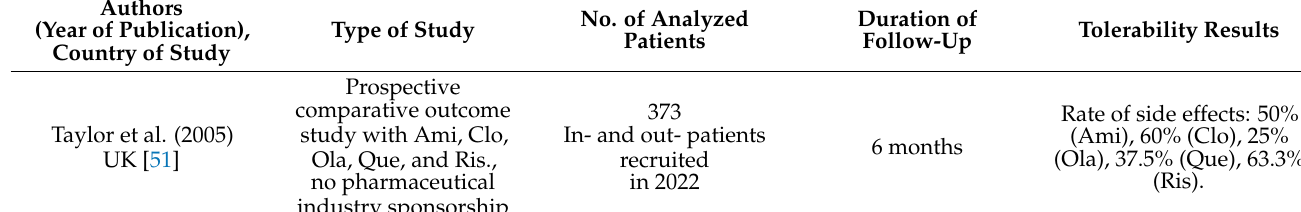
Table 3. Real-world population-based studies investigating the tolerability of oral and/or LAI formulations of SGAs in patients with schizophrenia and related